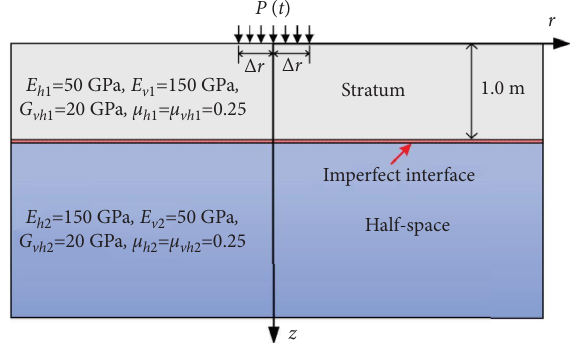
Figure 6: A crossanisotropic double-layered half-space medium with an imperfect